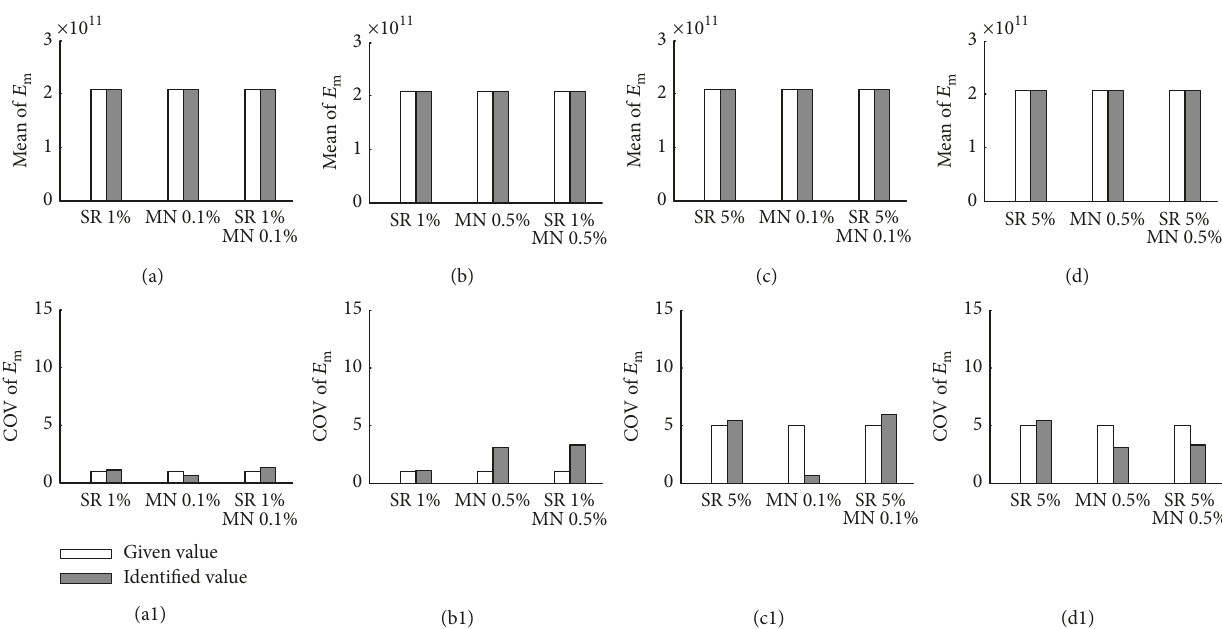
Figure 8: Means and COVs of elastic moduli of metal ( 𝐸 m ) for FGM along axial direction with different uncertainties.